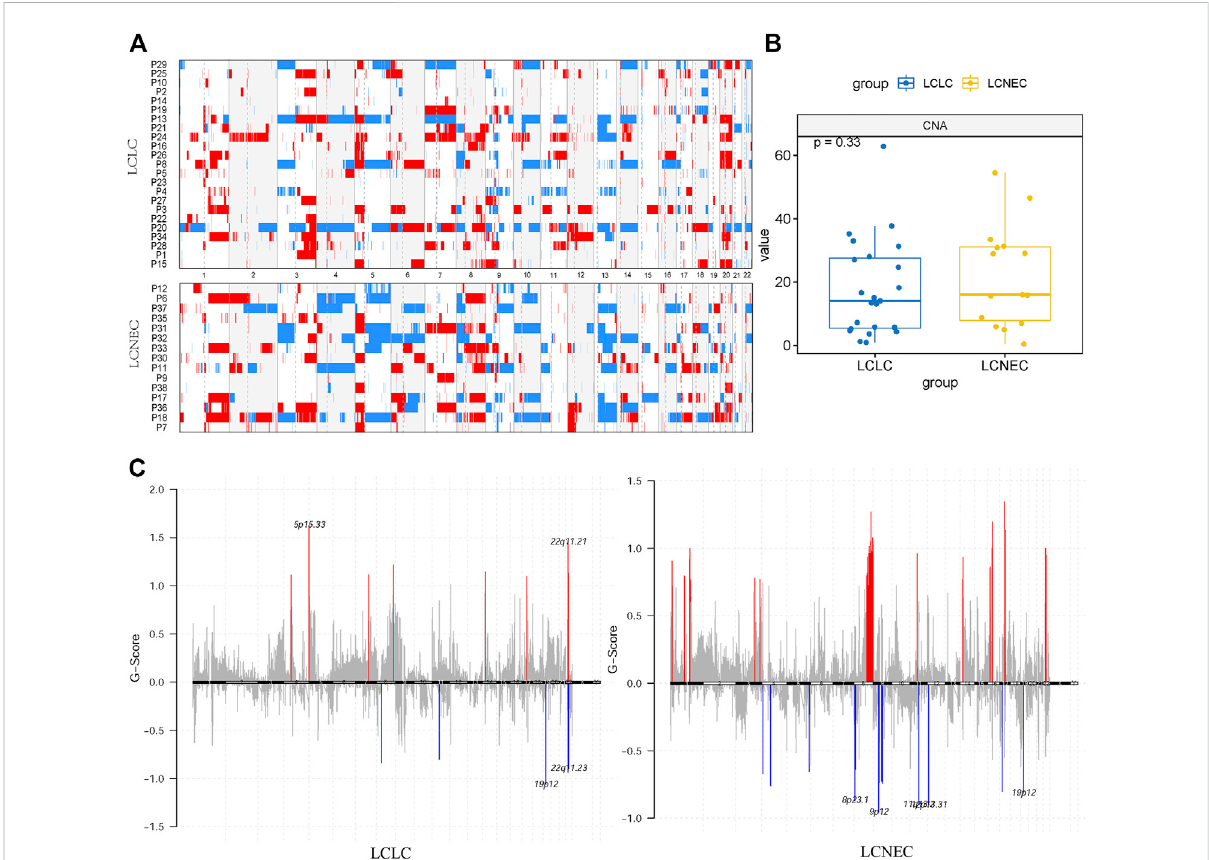
FIGURE 3 Distinct CNA landscape of LCLC and LCNEC. (A) Overall copy number variation (CNV) pro fi le of LCLC and LCNEC. Red represented ampli fi cation and blue represented deletion. (B) Comparison of the CNA burden between LCLC and LCNEC. (C) Somatic copy number alterations in each group. Deletions and ampli fi cations are represented on the y-axis by blue or red bars, respectively. Each peak region (cytoband) is displayed together with its known or potential cancer-related